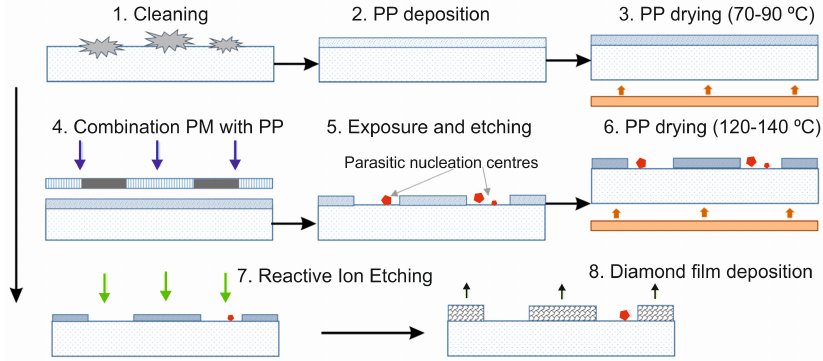
Figure 1. The technological route of obtaining a diamond coating pattern.